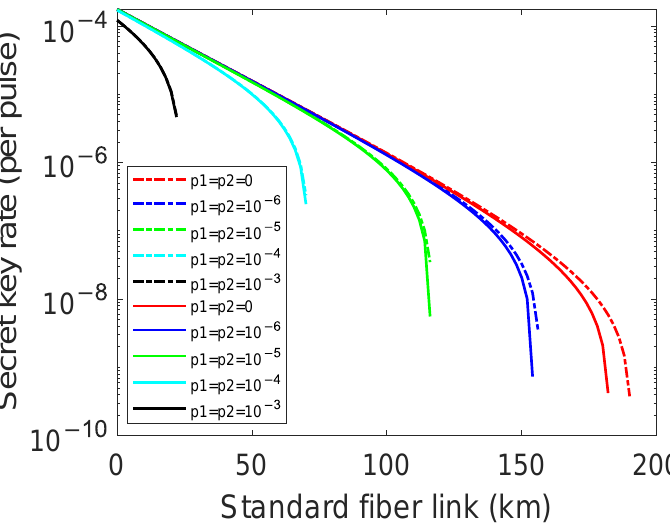
Figure 3. (Color online) The secret key rates (per pulse) in logarithmic scale versus transmission distance between Alice and Bob with p 1 = p 2 = 0,10 − x ( x = 6,5,4,3 ) (curves from right to left) for different N = 10 15 ,10 16 . The dashed lines are results of N = 10 16 with different weak random- ness parameters, and the solid lines are the results of N = 10 15 with different weak randomness